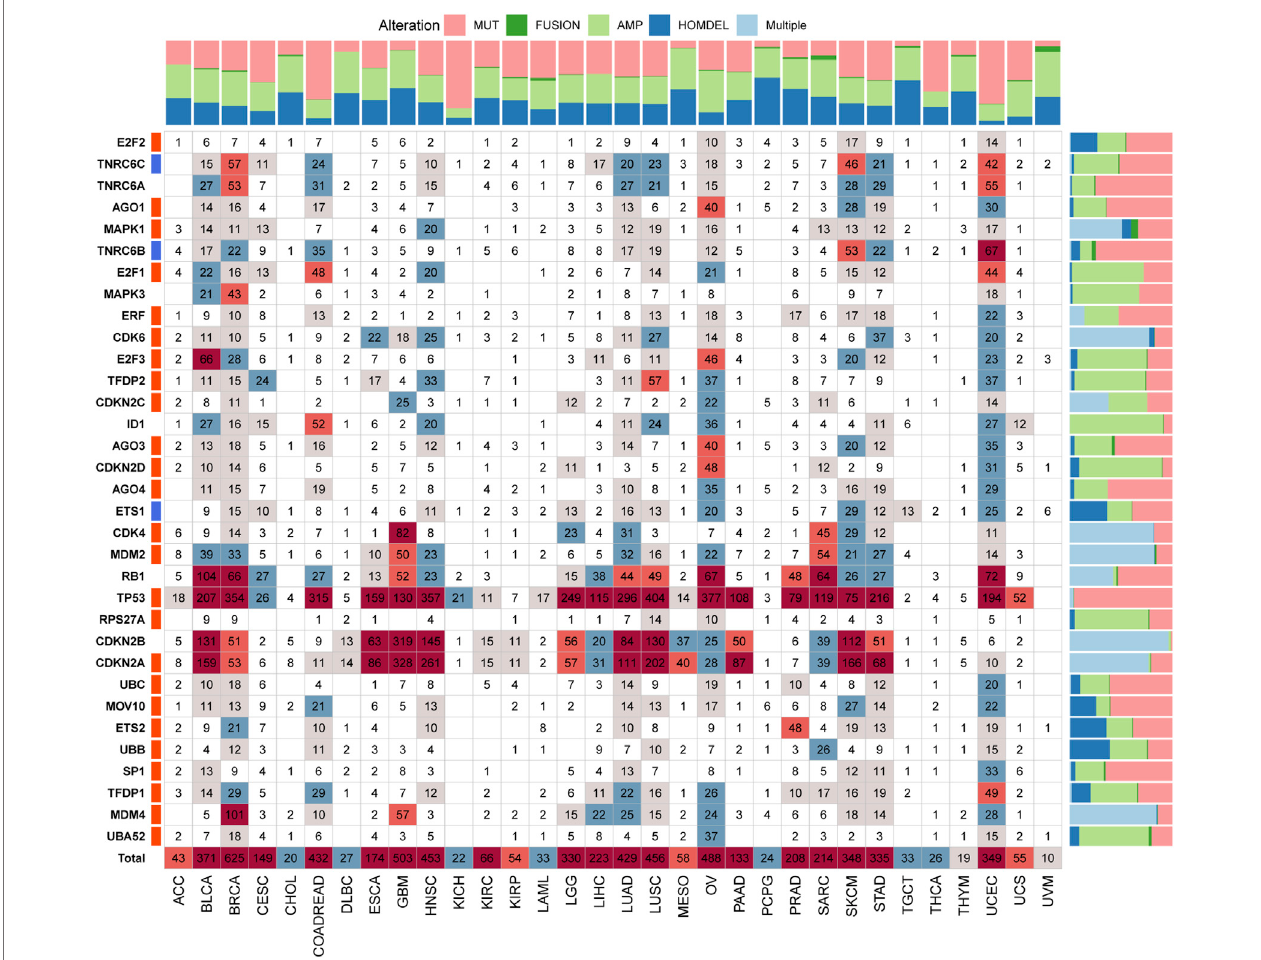
FIGURE 5 | The genetic alteration landscape of senescence-related genes (SRGs) in various cancers. In the pan-cancer, the genetic alterations of SRGs include mutations, fusions, ampli fi cations, deletions, and multiple variations. Numbers in the boxes represent sample sizes for genetic variants; the darker the color, the greater the number. Quanti fi ed data were plotted in bar graphs (MUT: mutation; AMP: ampli fi cation; HOMDEL: homozygous deletion; and Multiple: multiple